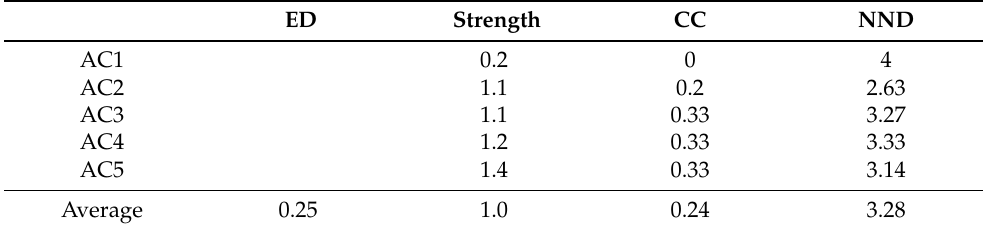
Table 1. Complexity indicators for G 1 .